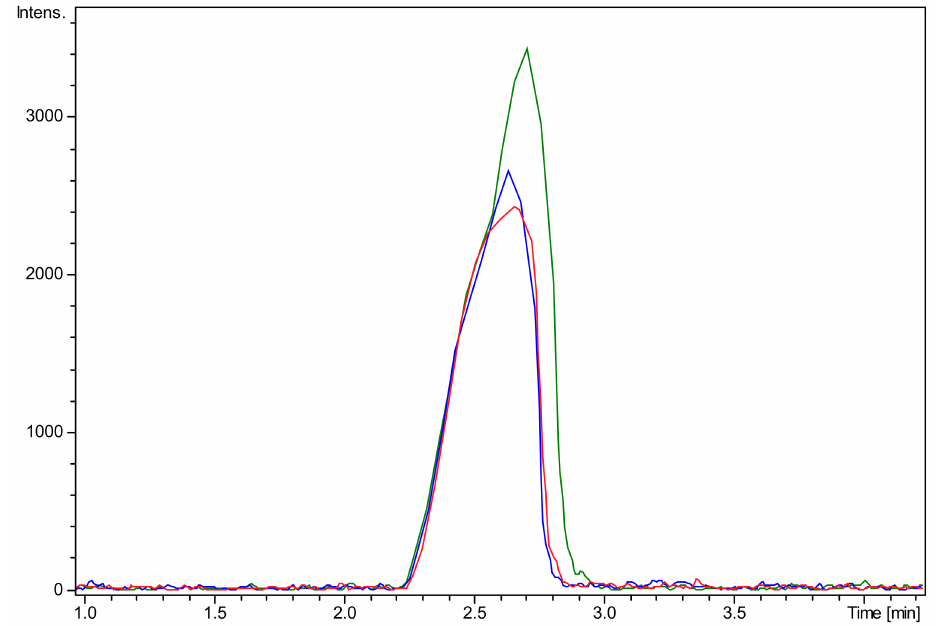
Figure 3. LC-MS/MS chromatograms (ESI-QTOF) obtained for the ion m/z 1133 present in the sample COS1 fractions. Blue: COS1G1; red COS1G2; and green